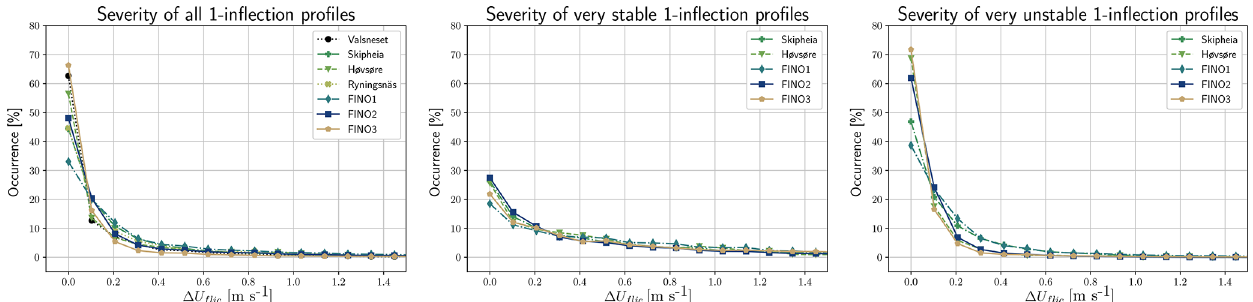
Figure 12. Inflection severity for 1-inflection profiles, (cid:49)U flic = U inflection − U min above inflection (ms − 1 ).